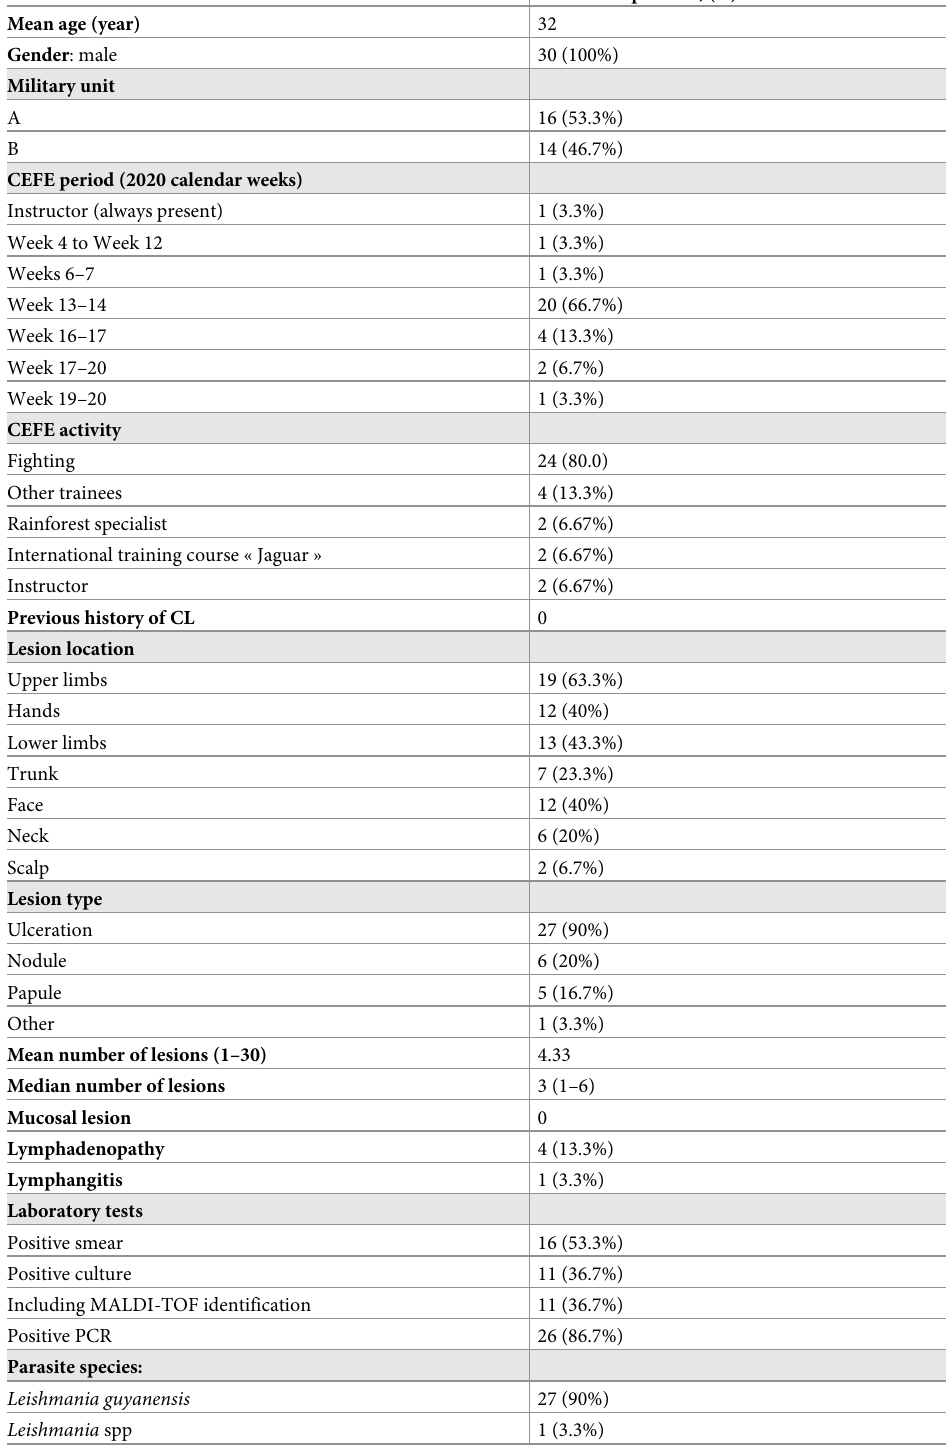
Number of patients,